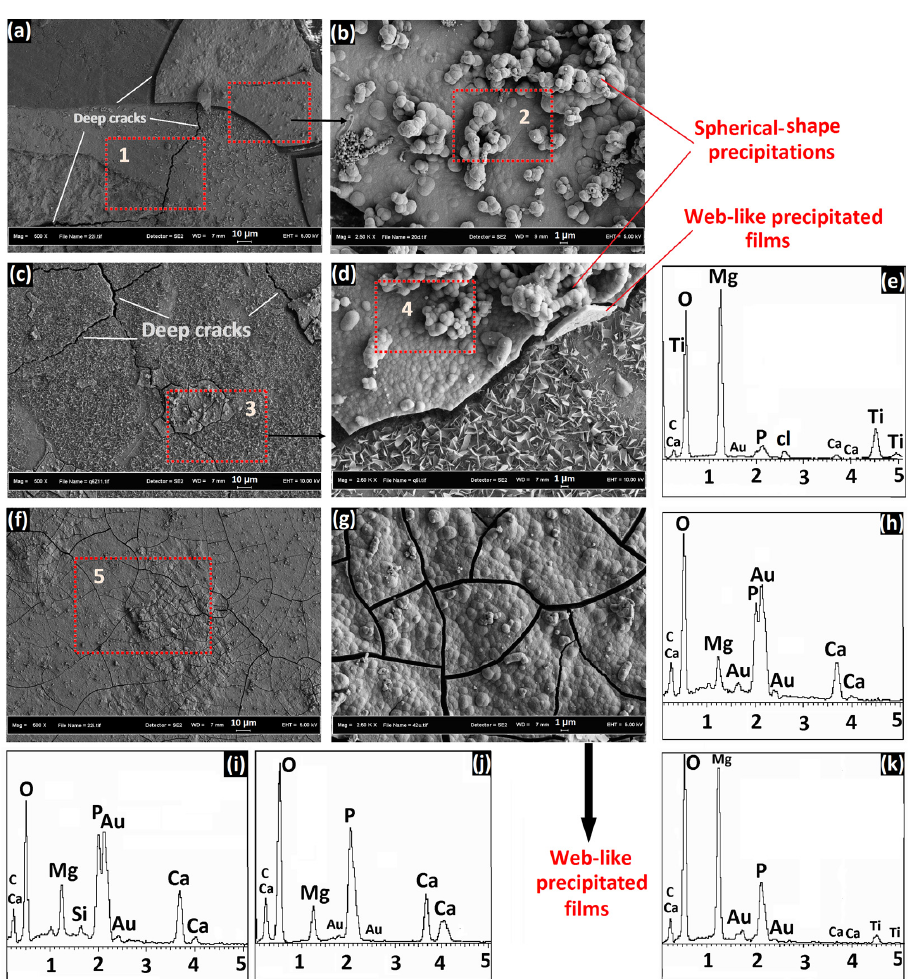
Figure 11. Surface FE ‐ SEM images of ( a , b ) uncoated ( c , d ) MgO ‐ coated; ( f , g ) Si/MgO coated and EDS analysis ( e ) area 1, ( h ) area 2, ( k ) area 3, ( j ) area 4 and ( i ) area 5 after 7 days of immersion in an SBF solution at 37 °C.